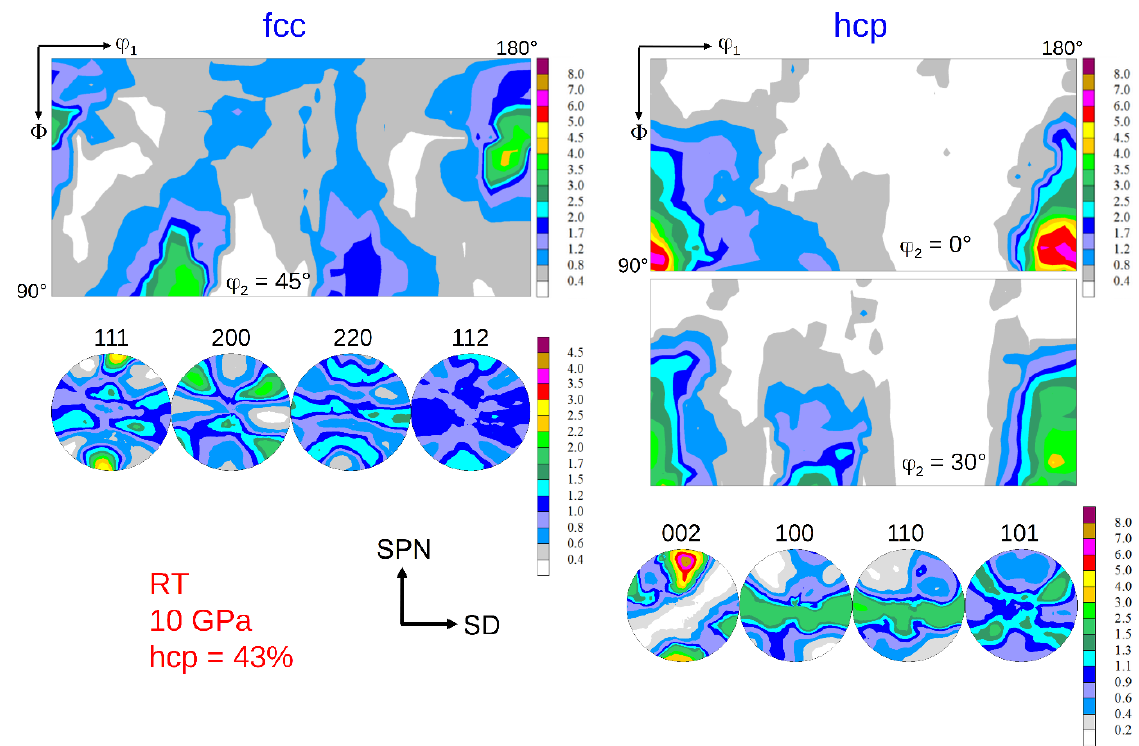
Figure 8. Texture of the fcc and hcp phase after HPT at RT at 10 GPa pressure and a shear strain γ = 94. The hcp volume fraction is 43%. (for key figures and designation of the fcc and hcp shear texture components see Figures 7 and 13 below, respectively).